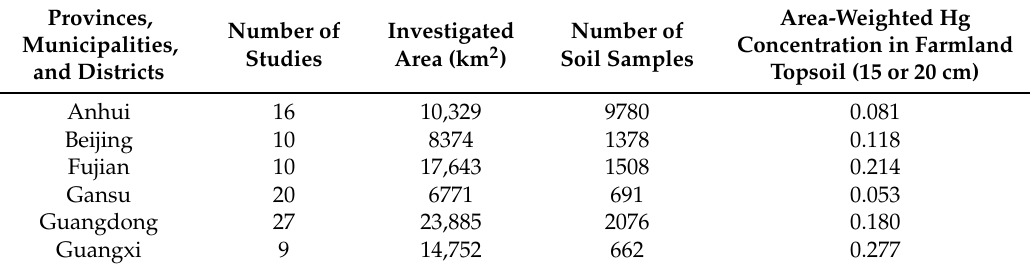
Table 1. Statistic information of Hg concentration in farmland soil on provincial